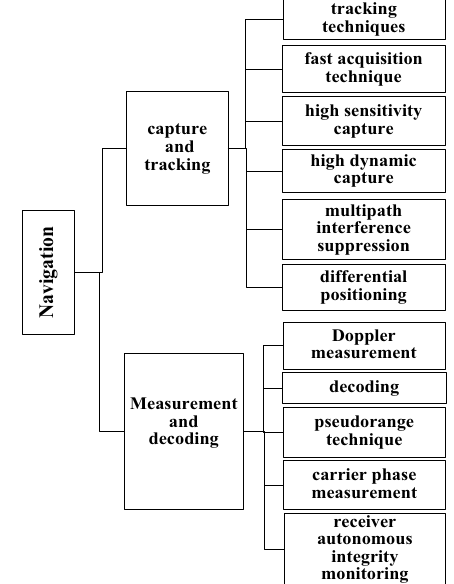
Fig.1. An example of technical taxonomy: a technical taxonomy of the specific technology area of